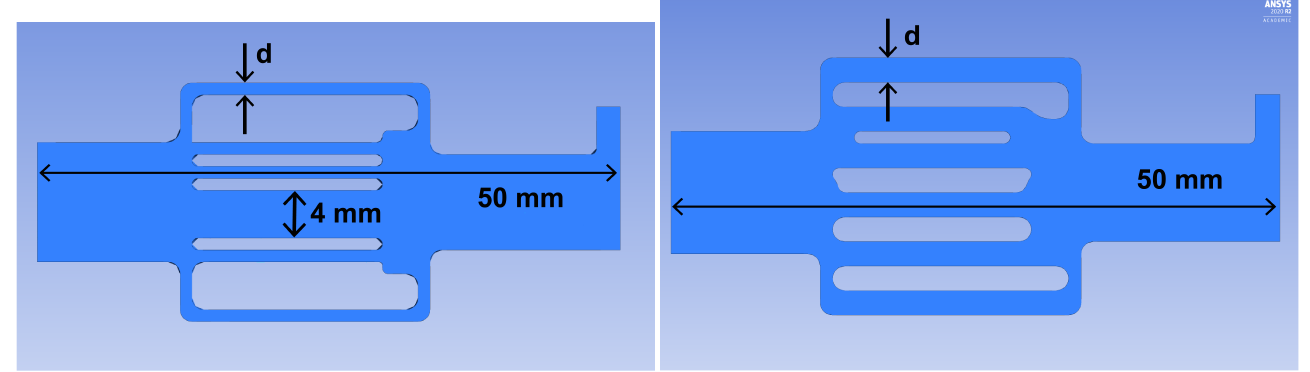
Figure 7. Geometry used for numerical calculations: AVM without fistula ( left ) with varying vessel diameter d ∈ ( 0.5,2 ) mm, AVM with fistula ( right ) 4 mm in diameter and varying vessel diameter d ∈ ( 0.5,2 )